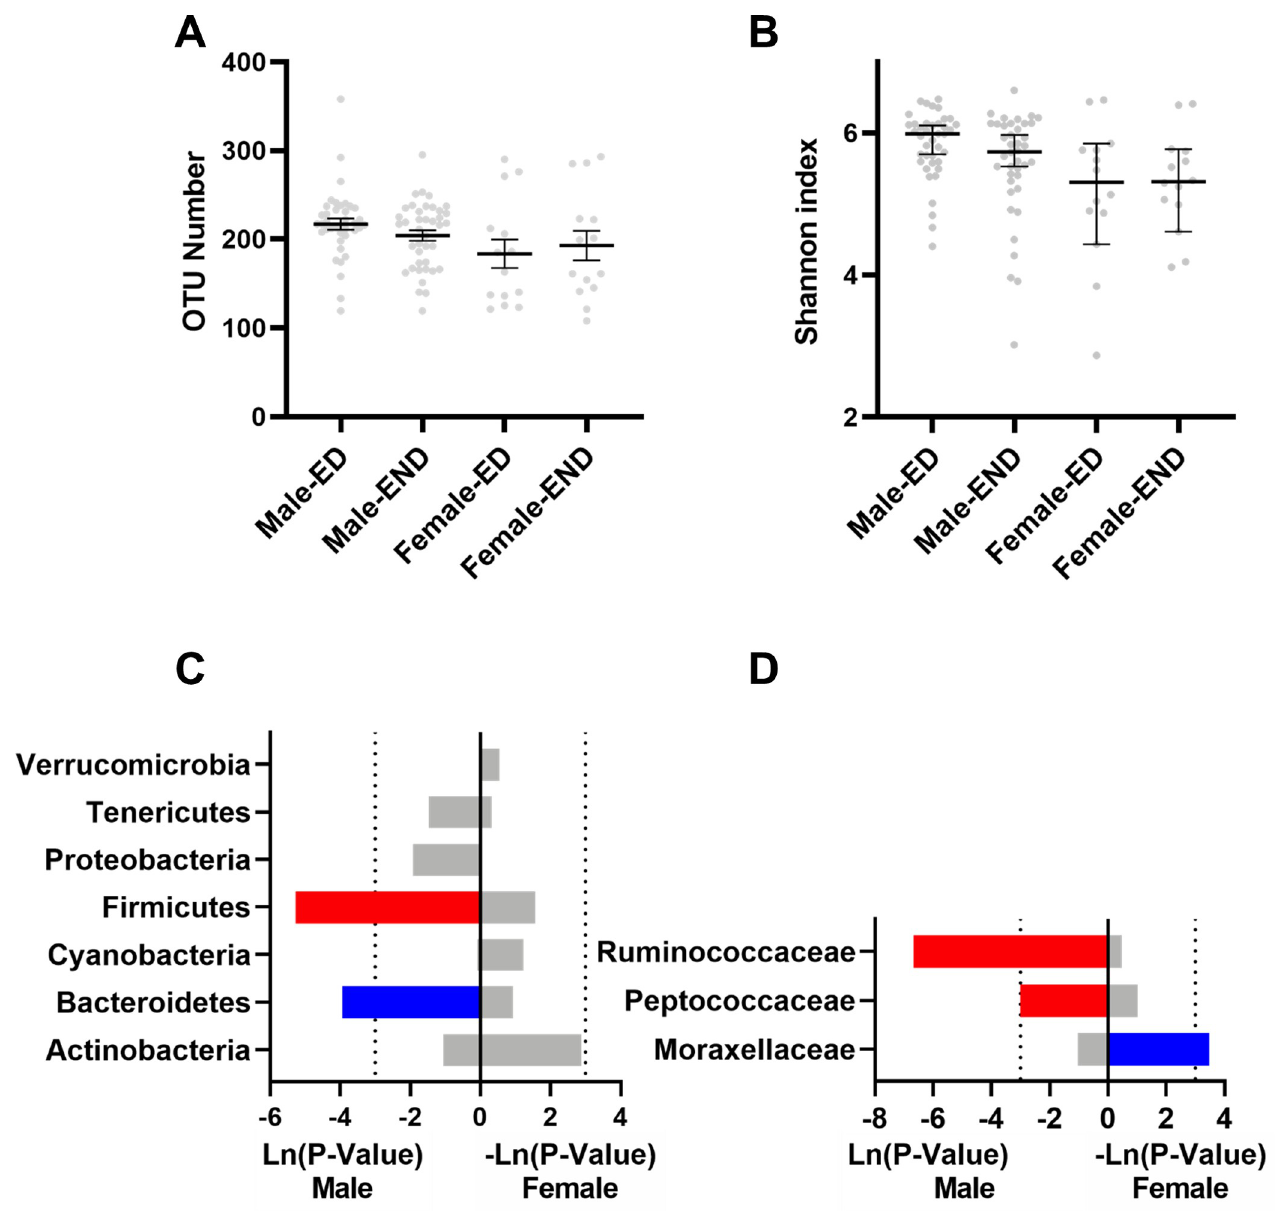
Fig 5. The effect of dog ownership on the microbial composition of normal-weight and overweight elderly individuals. Dog ownership did not affect the (A) number of OTUs or the (B) Shannon index. The effect of dog ownership on bacteria at the (C) phylum level and (D) family level. The red bar represents a significant increase, while the blue bar represents a significant